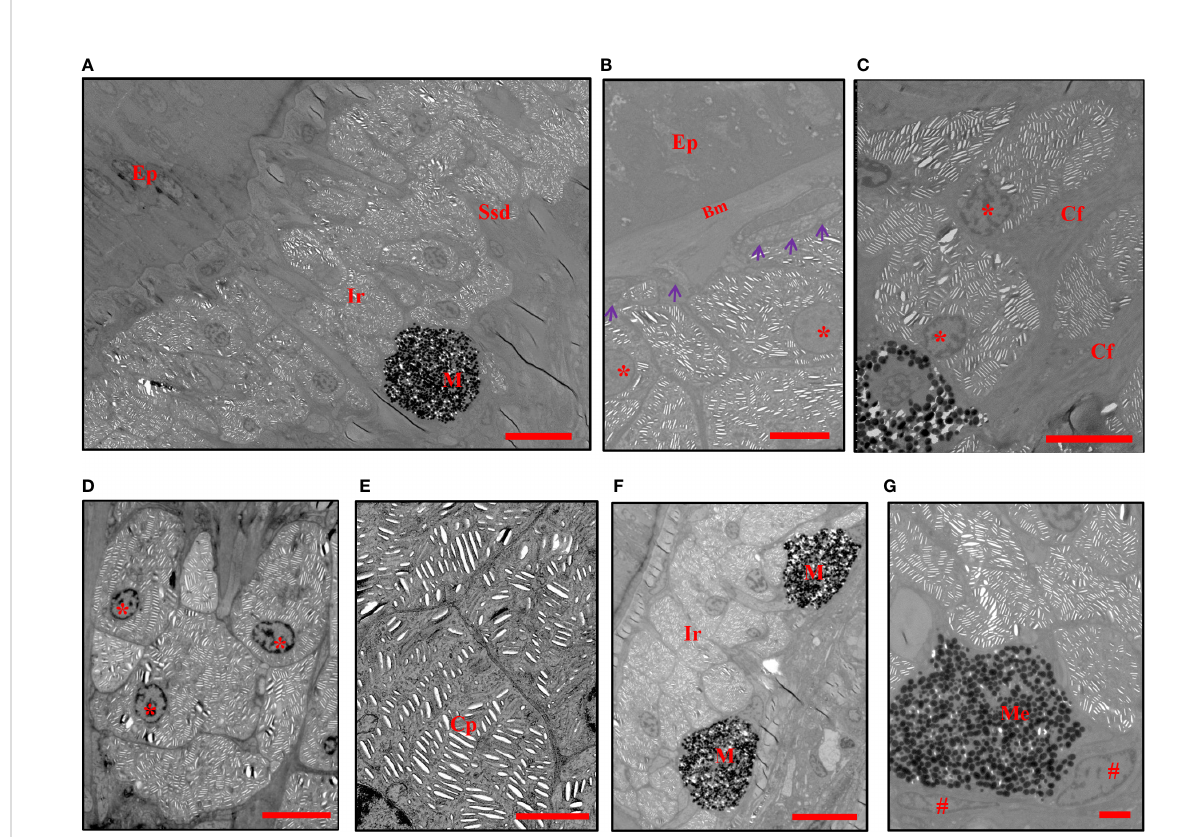
FIGURE 2 TEMs show the chromatophores in blue spots. (A) The iridophores and melanophores are located in the stratum spongiosum of the dermis. (B) The iridophores are located below the basal lamella without direct contact (purple arrowheads). (C, D) The arrangement and shape of iridophores. (E) Crystalline platelets within melanophores. (F) The melanosomes are totally aggregated in the perikarya of melanophores. (G) Melanophores are in direct contact with the lower surface of iridophores. Ep, epidermis, Ssd, stratum spongiosum of the dermis, Bm, basement membrane, Cf, collagen fi bers, M, melanophores, Me, melanosomes, Ir, iridophores, Cp, crystalline platelets. The nuclei of iridophores are indicated with an asterisk *, and those of melanophores are indicated with a pound sign #. Scale bars: 10 m m (A, F) ; 5 m m (B – D) ; 2 m m (E, G)